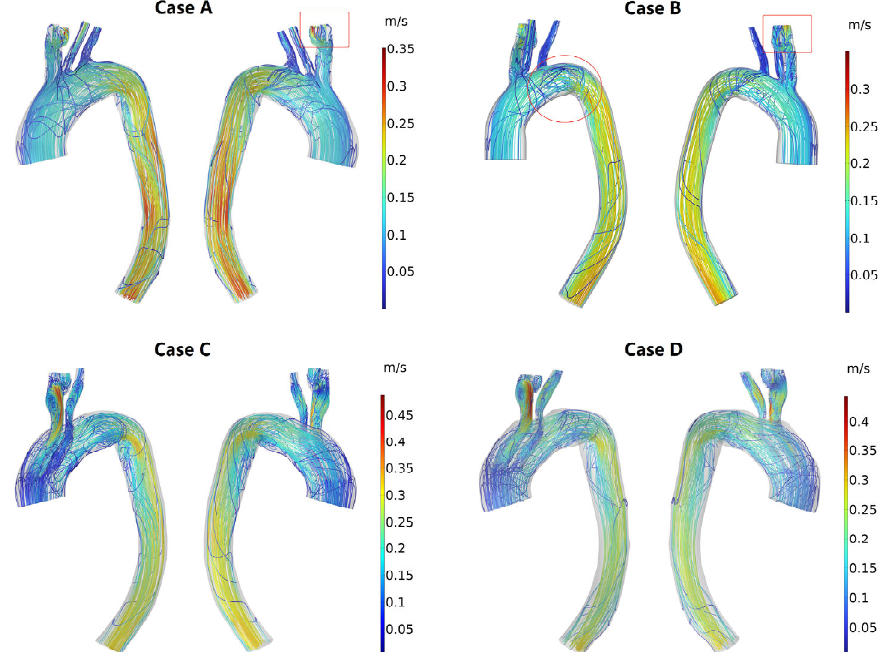
Figure 6. Intravascular flow field at peak systole. (Case A ) Normal model; (Case B ) Preoperative model; (Case C ) 1-week postoperative model; (Case D ) 6-week postoperative model. The dashed circle is proximal to the third module and adjacent to the overlapping area of the branched stent and aortic stent. The red arrow indicates an area of disturbed blood flow along the lesser curvature of the aorta.